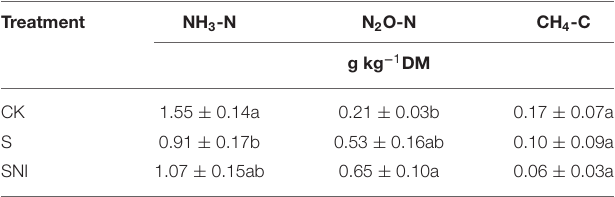
TABLE 5 | Yield-scaled gas emissions per dry matter of grass from control (CK), DFE (S), and DFE plus nitrapyrin (SNI) of a field trial conducted in 2017 on a permanent pasture in the Alfredo Volio Mata Experimental Station, Costa